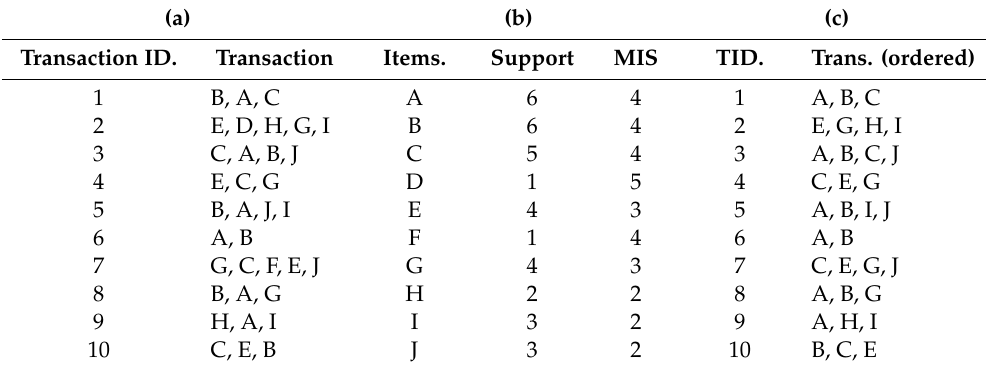
Table 4. Transaction database, actual support and multiple item supports (MIS) of each